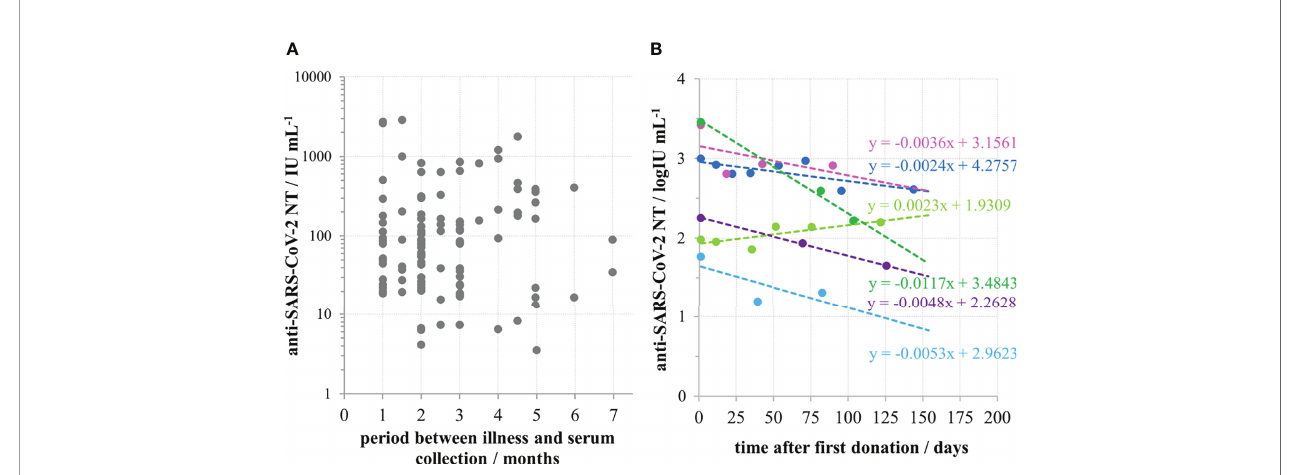
FIGURE 3 | Persistence of anti-SARS-CoV-2 neutralizing antibodies in convalescent sera. (A) Neutralisation titre in convalescent donors ’ sera ( n =113) in relation to the time period between the illness and serum collection. (B) Longitudinal monitoring of neutralisation titre in sera of six convalescents.